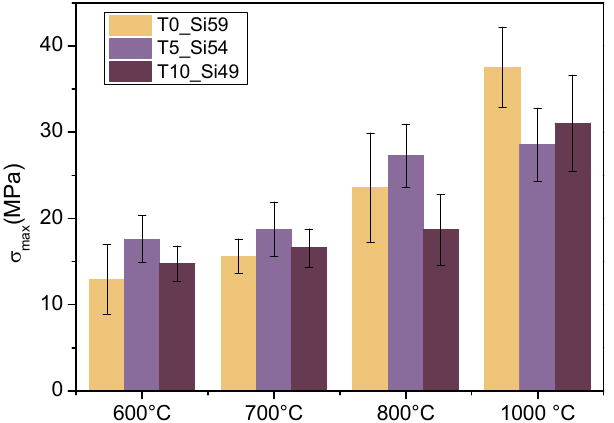
Figure 8. Flexural strength (σ max ) for tapes T0_Si59, T5_Si54, and T10_Si49 pyrolyzed at 600–1000 °C.